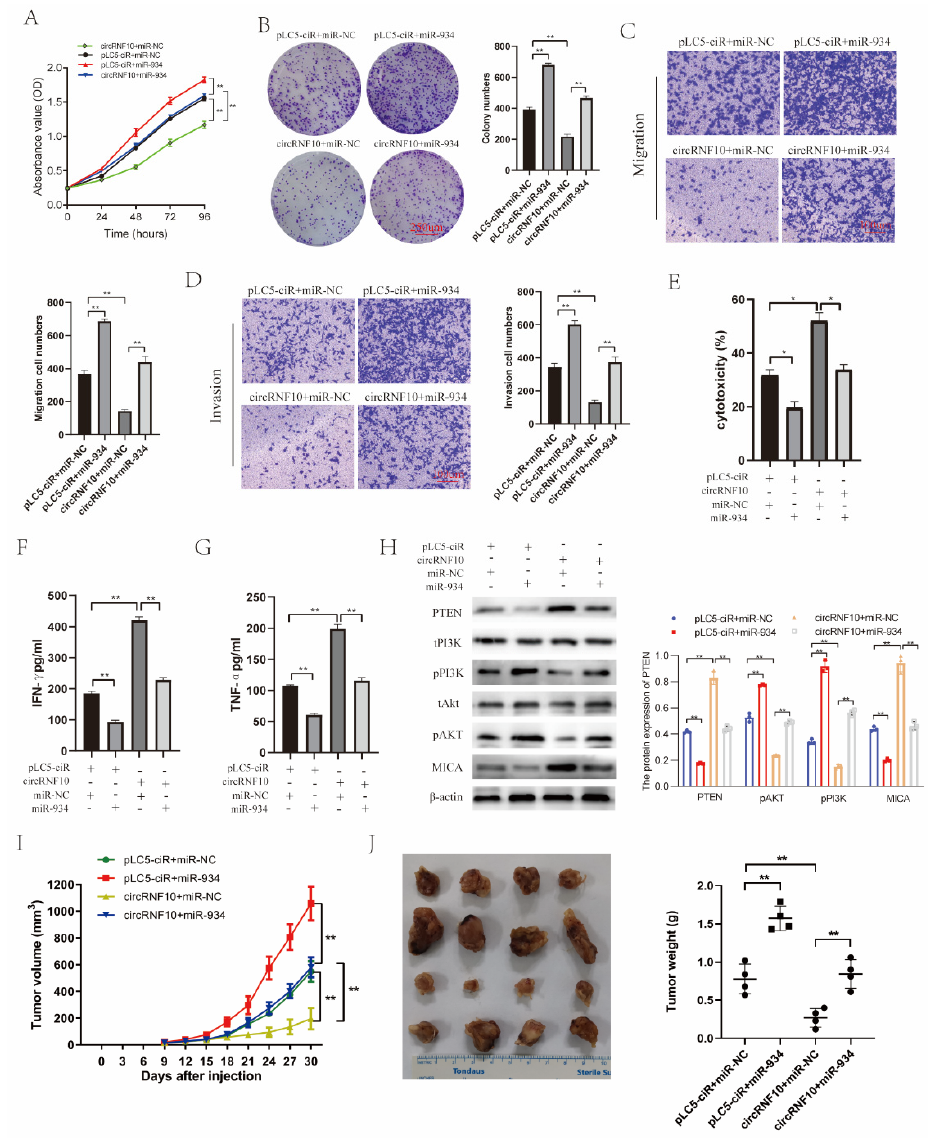
Figure 7. circRNF10 regulates miR-934 to affect BC cell proliferation, migration, and invasion, as well as the killing efficiency of NK-92MI cells on BC cells and may have an effect on the PI3K-Akt pathway. BC cells were co-transfected with circRNF10, pLC5-ciR, miR-934, or NC. ( A , B ) Proliferation of BC cells was detected by CCK-8 and colony formation assays, respectively. Scale bar, 250 µ m. Experiments were repeated thrice. ** p < 0.01. ( C , D ) Cell migration and invasion were determined using Transwell migration and invasion experiments, respectively.Scale bar, 100 µ m. Experiments were repeated thrice. ** p < 0.01. ( E ) NK-92MI cell killing ability against MDA-MB-231 cells was determined by the LDH assay. Experiments were repeated thrice. * p < 0.05. ( F , G ) Protein levels of IFN- γ ( F ) and TNF- α ( G ) in supernatant of NK-92MI cells were observed by ELISA. Experiments were repeated thrice. ** p < 0.01. ( H ) Protein levels of PTEN, tPI3k, pPI3k, tAKT, pAKT, MICA, and β -catenin were detected by Western blotting. ** p < 0.01. ( I , J ) Tumor growth and tumor weight were evaluated. ** p < 0.01. The uncropped western blot figures for relevant results are shown in Figure